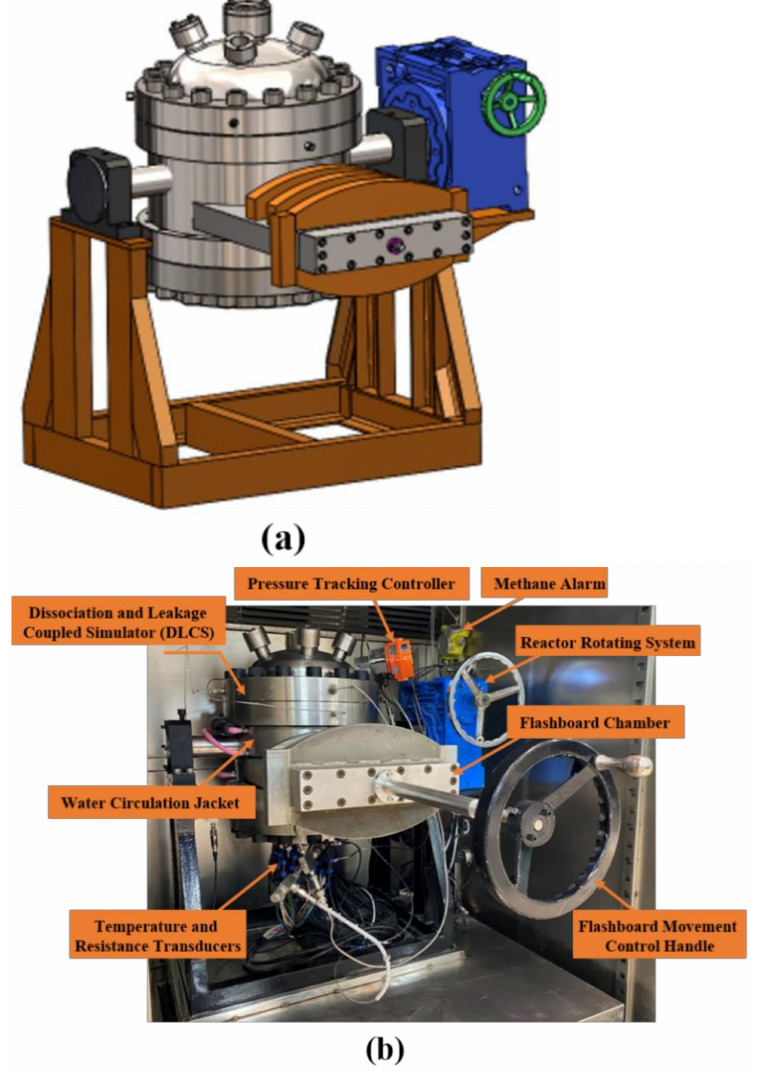
Figure 1. Schematic diagram of the DLCS. ( a ) 3D model drawing, ( b ) physical drawing.